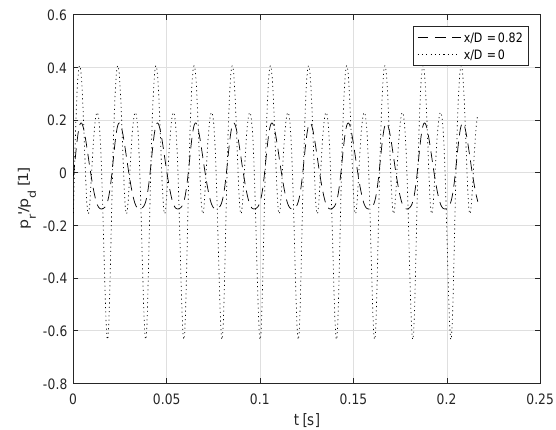
Fig. 4. Prediction of the static pressure fluctuations behind the circular cylinder for Re = 157 140 at two